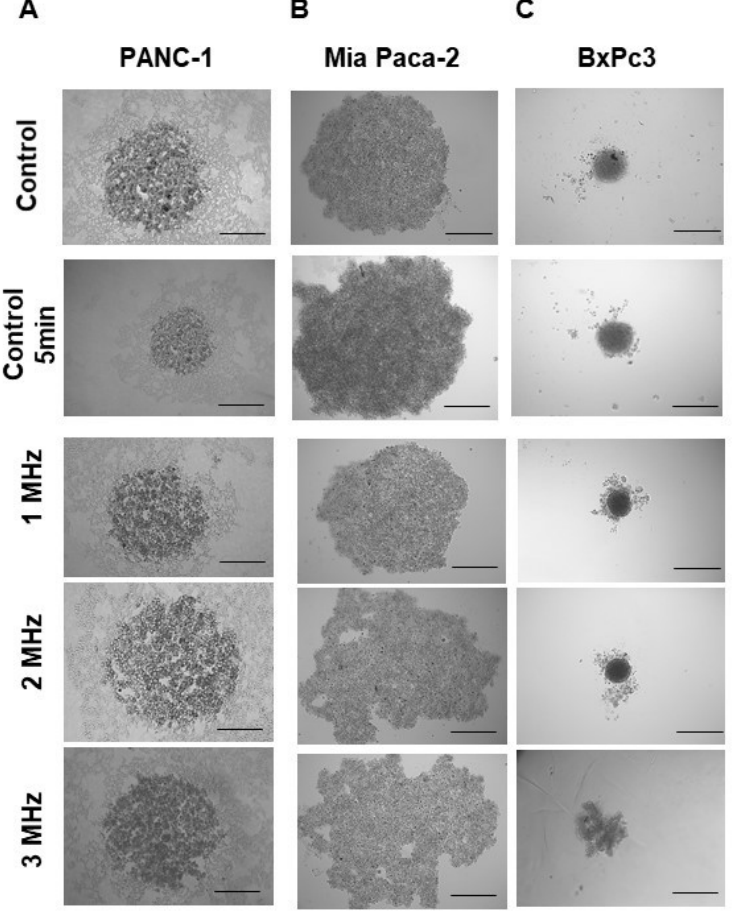
Figure 8. Brightfield images of PANC-1, Mia Paca 2 and BxPc3. ( A ) PANC-1 images of spheroids, control (untreated cells), control after 5 min (Control 5 min) of stimulation, cells treated with 1 MHz, 2 MHz and 3 MHz. ( B ) Mia Paca 2 images of spheroids, control (untreated cells), control after 5 min (Control 5 min) of stimulation, cells treated with 1 MHz, 2 MHz and 3 MHz. ( C ) BxPc3 images of spheroids, control (untreated cells), control after 5 min (Control 5 min) of stimulation, cells treated with 1 MHz, 2 MHz and 3 MHz (scale bar: 100 μ m).